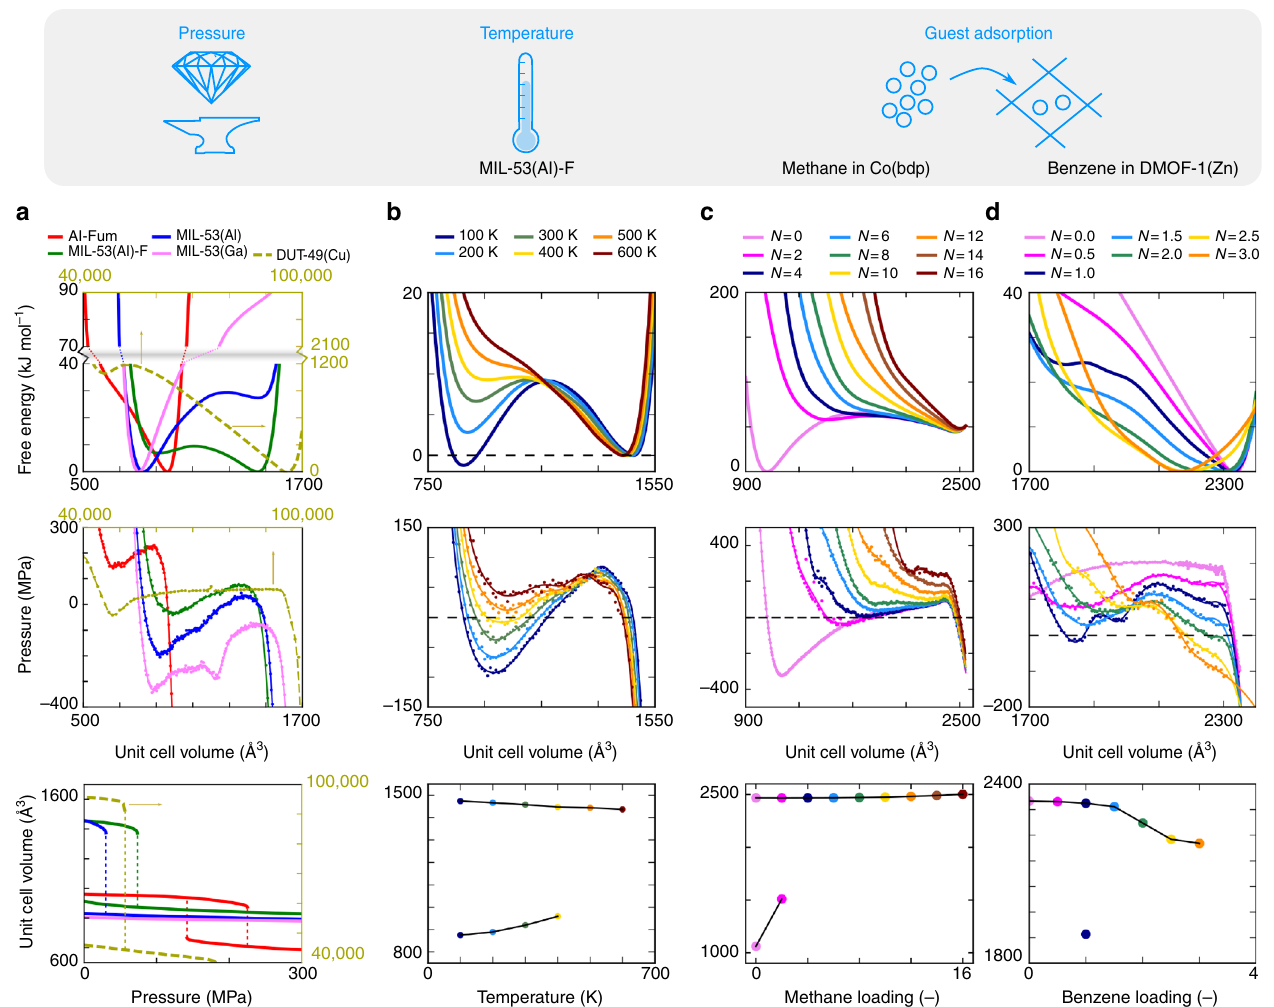
Fig. 4 Illustration of the mechanical equations of state for a variety of materials. Upper row: free energy pro fi le; middle row: mechanical equations of state; bottom row: volume versus external trigger. a Free energies, mechanical equations of state P NT ( V ) and V( P ) pro fi les for Al-Fumarate, MIL-53(Ga), MIL-53 (Al)-F, MIL-53 and DUT-49(Cu) (DUT-49(Cu) axis are shown in olive green). b Free energies, mechanical equations of state P N ( V ; T ) and V ( T ) pro fi les for MIL-53(Al)-F. c , d Free energies, mechanical equations of state P T ( V ; N ) and V( N ) pro fi les for methane@Co(bdp) and